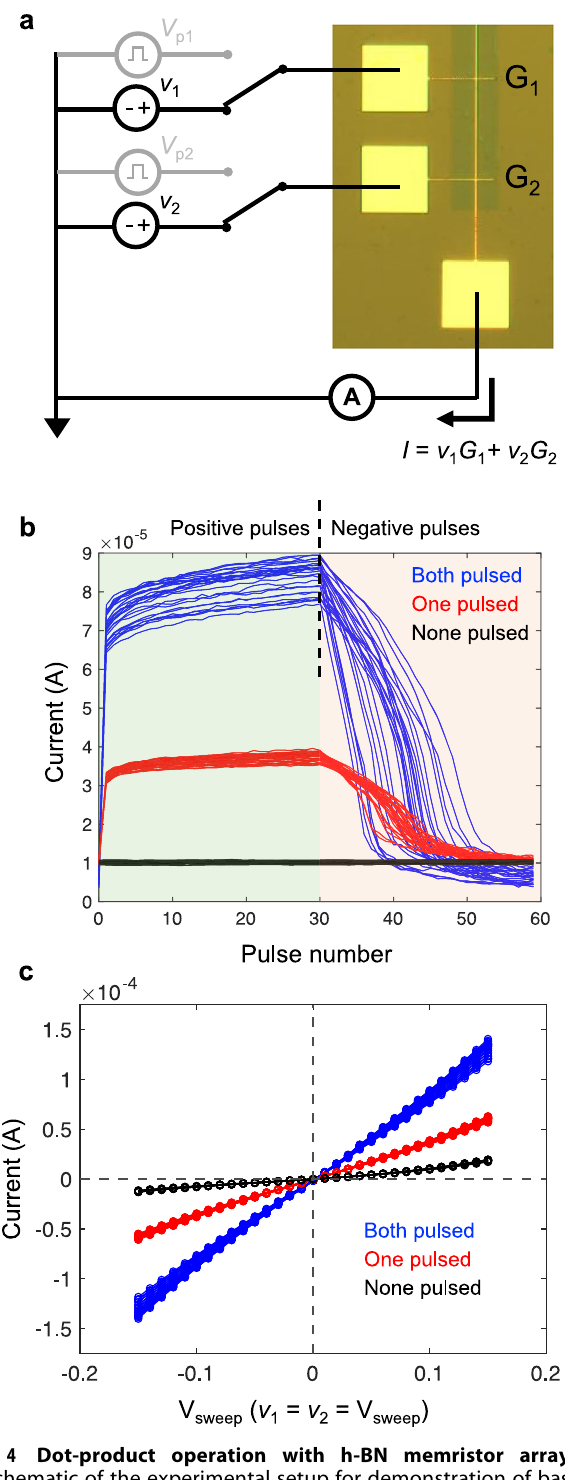
Fig. 4 Dot-product operation with h-BN memristor arrays. a Schematic of the experimental setup for demonstration of basic dot-product operation in h-BN memristor arrays. b Three different cases of pulse programming the memristor arrays: pulsing both memristors, pulsing just one, pulsing none (20 cycles for each case), a read voltage of V read = 0.1 V used to measure current after each pulse. c For each cycle in part ( b ) we also sweep the read voltage V sweep between − 0.15 and + 0.15 and measure total current to show the linearity and repeatability of the dot-product operation. The sweeps are done after the 30 positive pulses for each